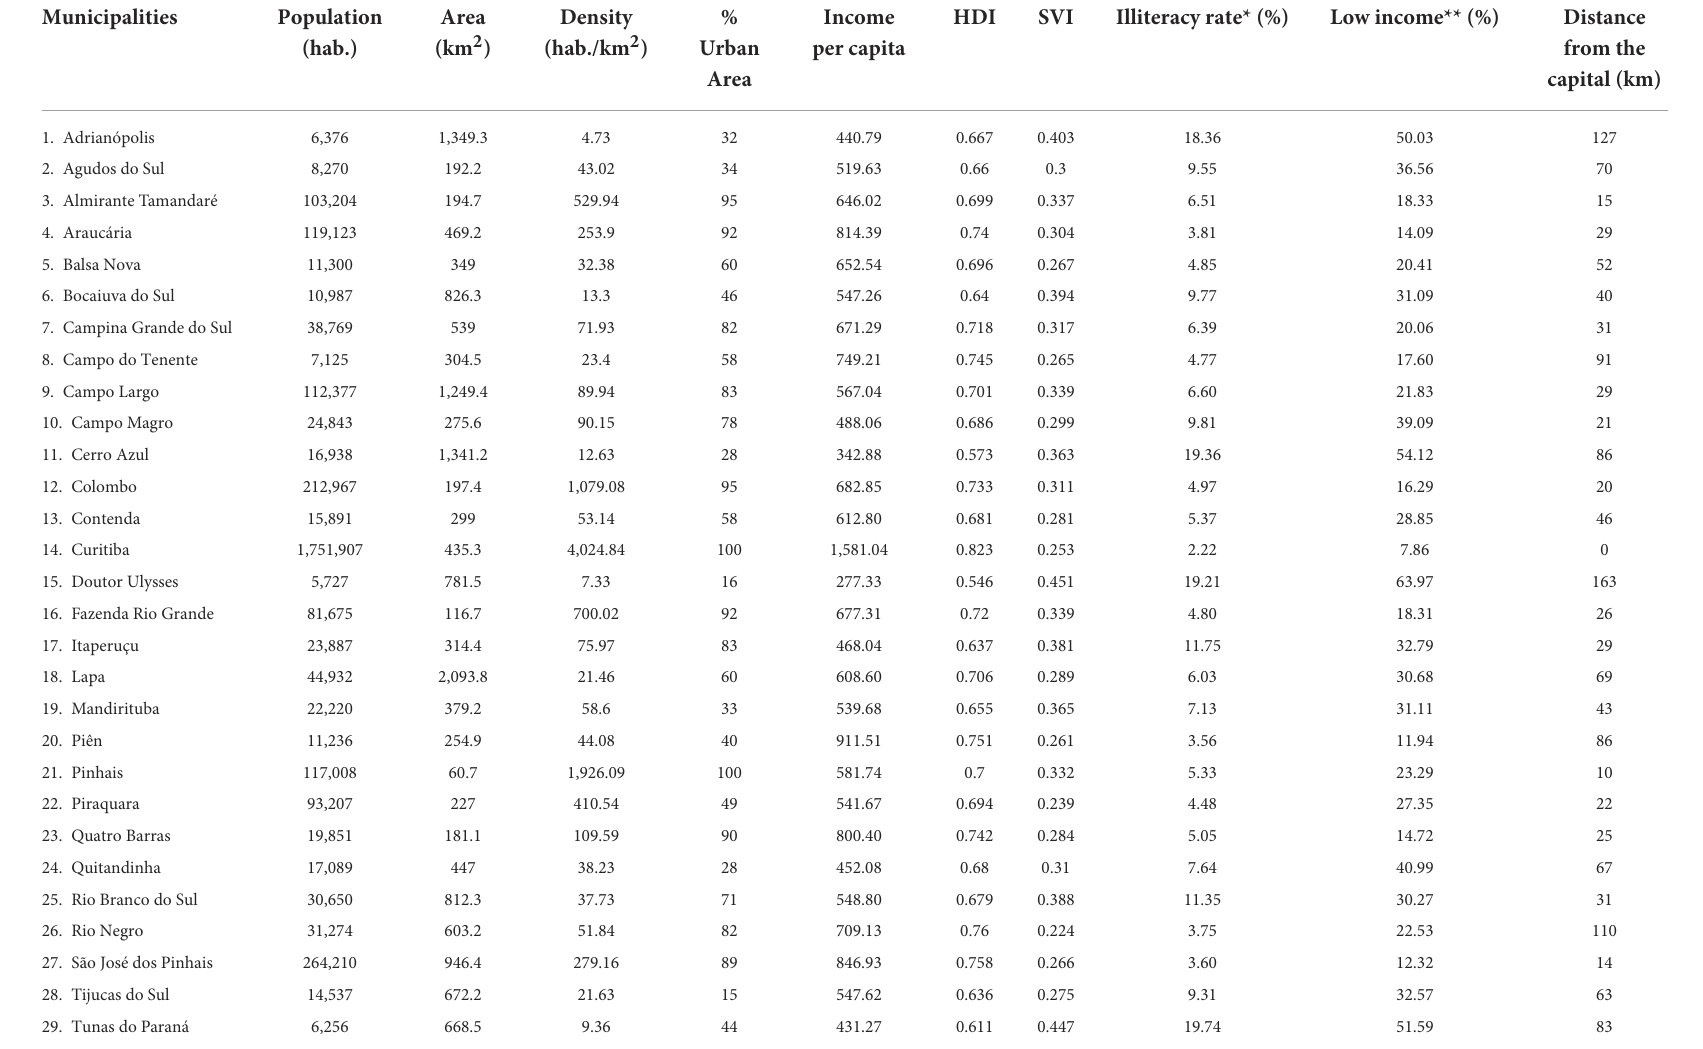
TABLE 3 Main geographical, economic, and social indicators of the 29 cities included in the metropolitan area of Curitiba, Parana State,